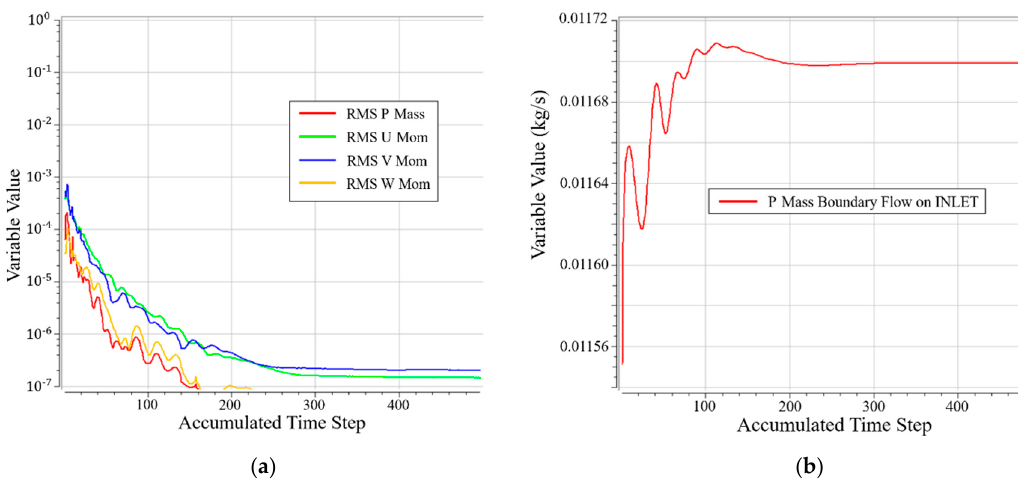
Figure 3. Convergence of the simulation for the 2D tandem blade model; incidence = − 1 ◦ , inlet Mach = 0.8. ( a ) Momentum and mass; ( b ) mass flow rate on INLET.